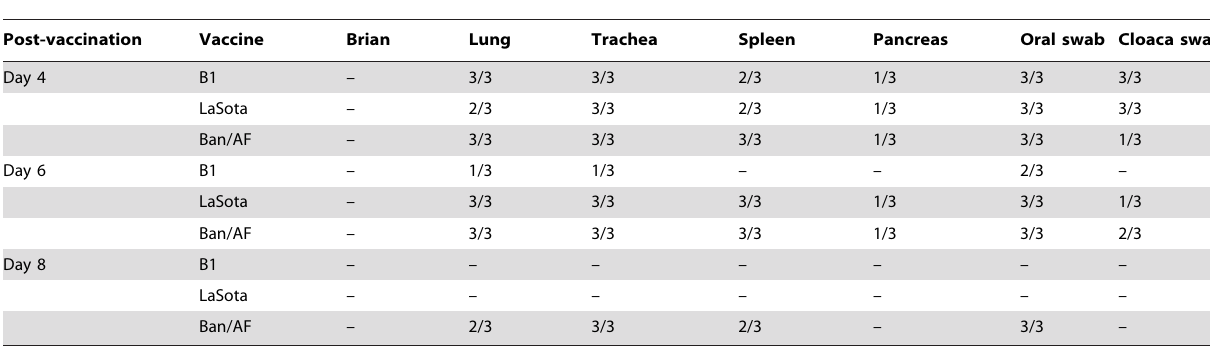
Table 5. vaccine virus replication and shedding in 1-day old chicks.